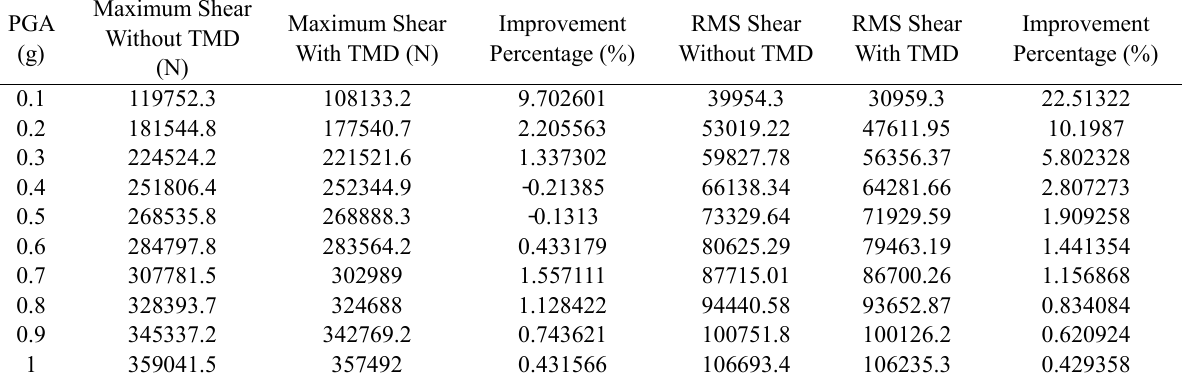
Average Maximum value and RMS of Base Stress and of the Roof of an Irregular Mass Structure, on the first floor, based on Near-Field